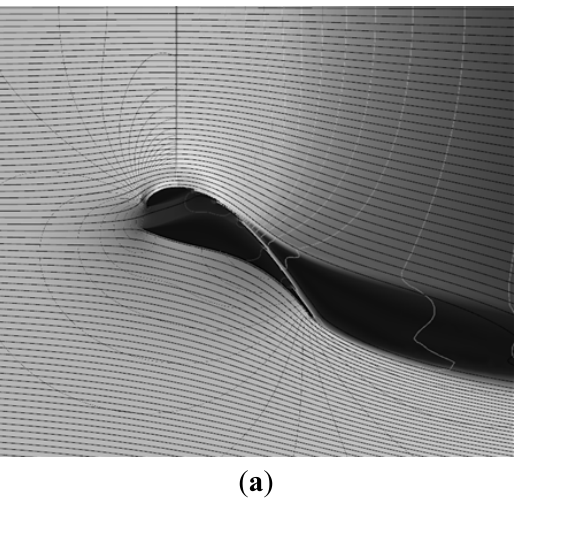
Figure 9. ( a ) Vortec original multi-slotted DAWT; ( b ) Vortec Mo multi-slotted DAWT. Power-optimal loading configurations are